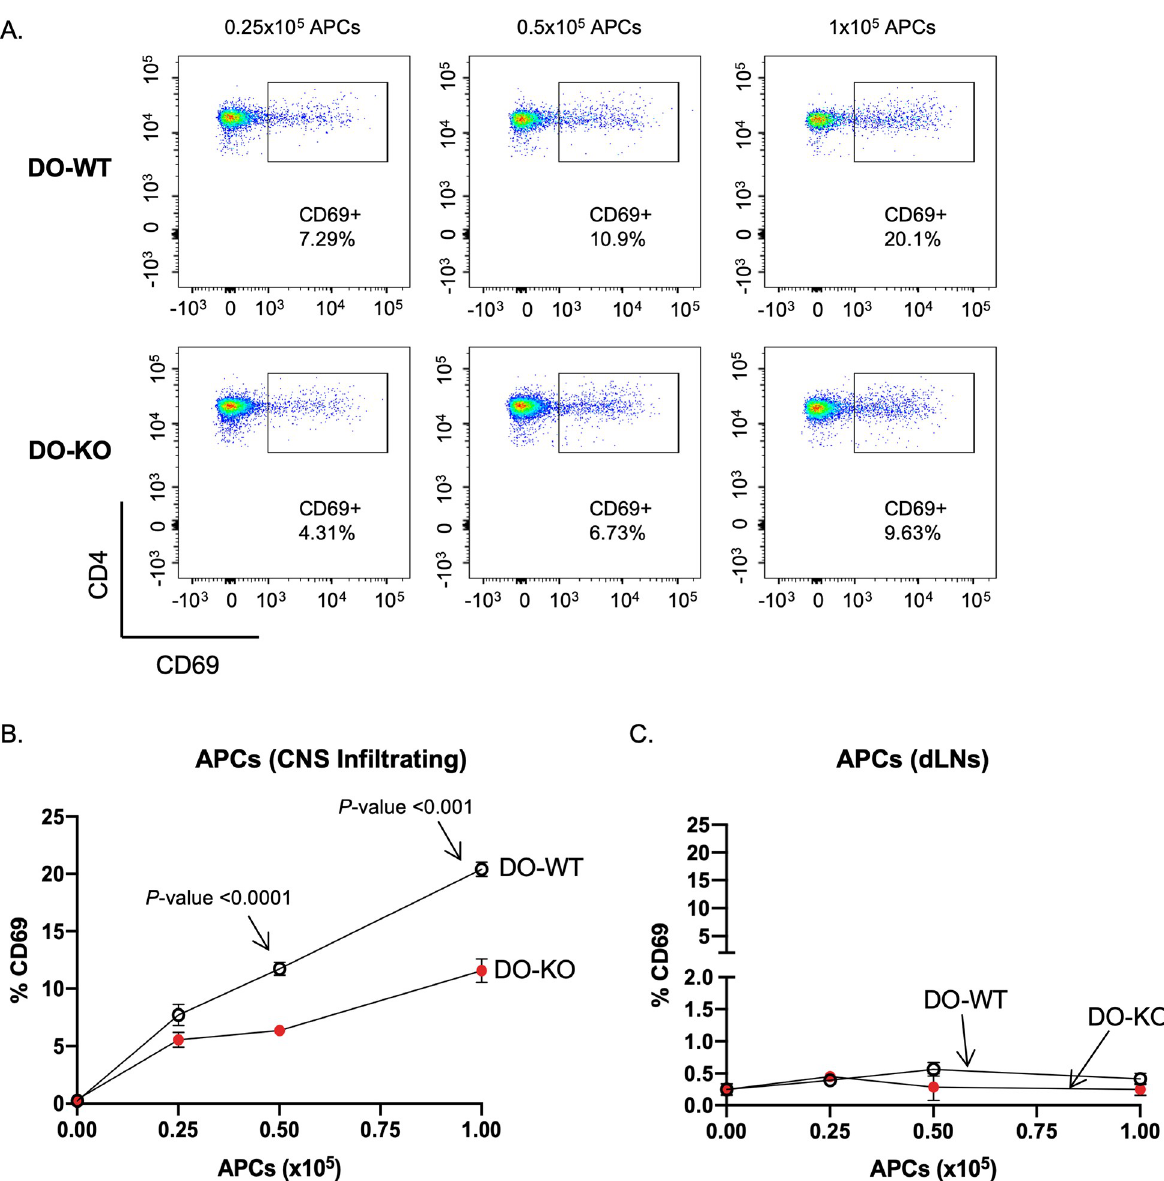
Fig 8. CNS infiltrating APCs from DO-KO mice are less stimulatory to 2D2 T cells. (A) Representative FCS plots showing one of the three replicates of the 2D2:APC coculture experiments. Freshly isolated 2D2 Tg CD4 T cells were cocultured with various APC concentrations (0.25 × 105, 0.5 × 105, and 1 × 105) isolated from the pooled CNS tissue of either DO-WT (top) or DO-KO (bottom) mice. (B) APCs isolated from the CNS of DO-KO mice present less of the MOG35–55 epitope compared to DO-WT despite having a more advanced disease phenotype. (C) Differences in presentation were not seen with APCs isolated from the dLN of the diseased mice. Data represented as mean ± SEM. N = 4 diseased mice pooled, each dilution plated in triplicates. Repeated in two independent experiments. Experimental results depicted in this figure can be found in S8 Data. APC, antigen-presenting cell; CNS, central nervous system; dLN, draining lymph node; DO, H2-O; FCS, flow cytometry; KO, knockout; MOG, myelin oligodendrocyte glycoprotein; Tg, transgenic; WT, wild-type.